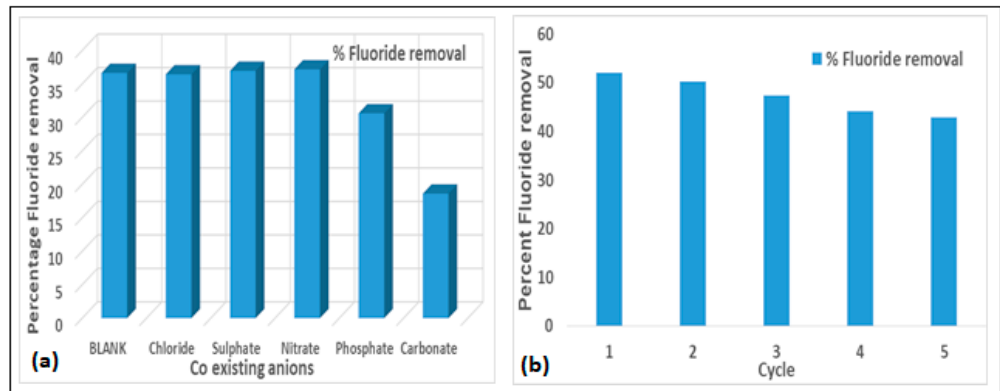
Figure 7. ( a ) Effects of co-existing anions on fluoride removal by the activated clay (at 10 mg/L fluoride, 2.0 g/100 mL adsorbent dosage and 30 min contact time at 250 rpm) and ( b ) Percent fluoride removal by activated clay in successive cycles (at 5.44 mg/L fluoride, pH 6.0 and 60 min contact time at 250 rpm).